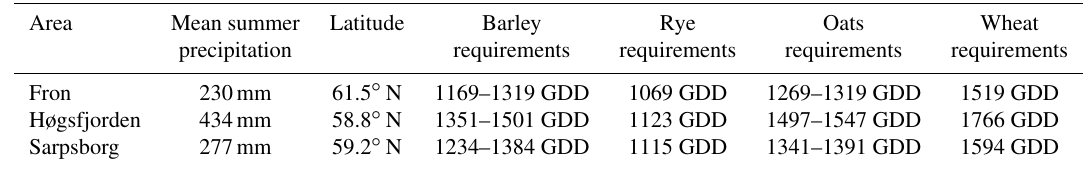
Table 2. Information about the three different sites for the growing degree day modeling, based on local growth conditions and 1961–90 meteorological data for each